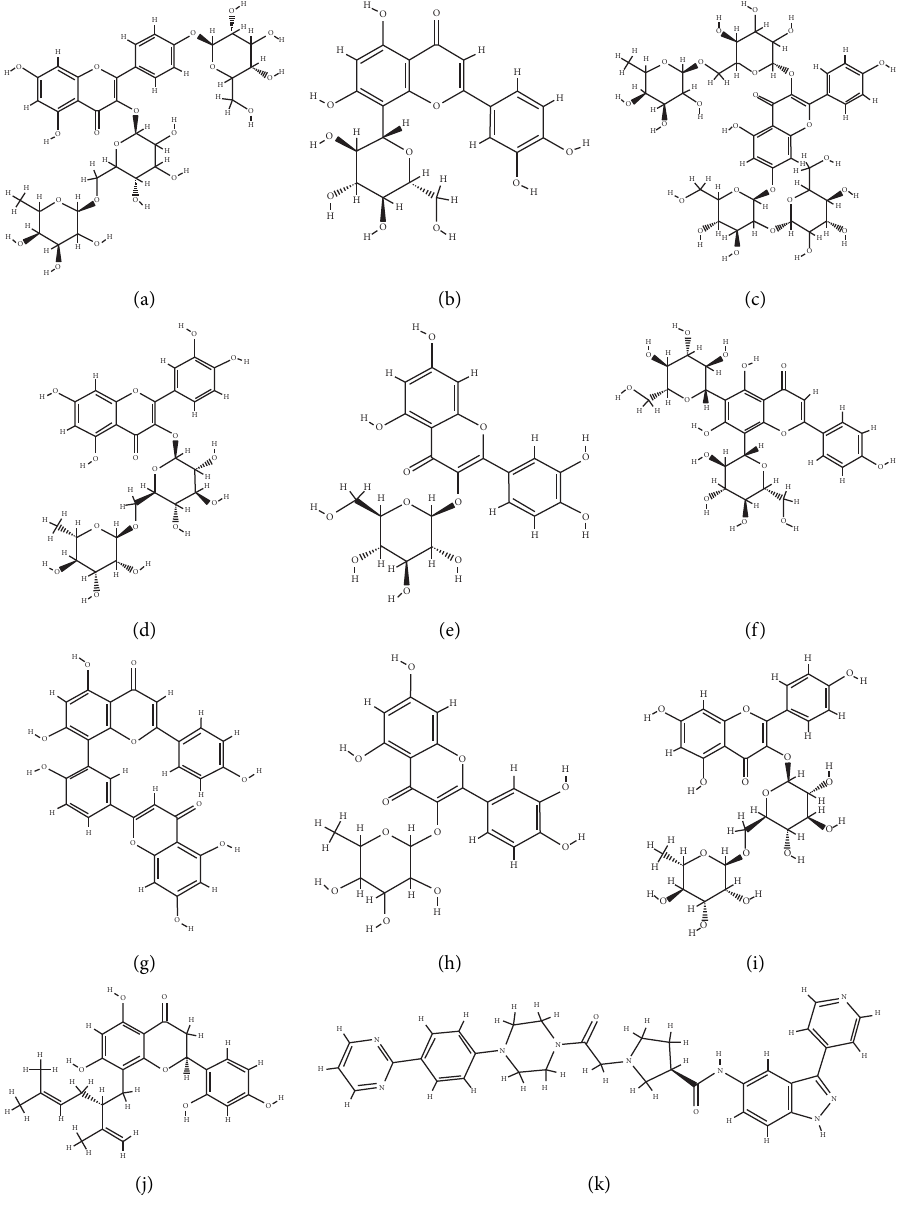
Figure 1: Chemical structures of (a) kaempferol 3-rutinoside-4 ′ -glucoside, (b) orientin, (c) kaempferol 3-rutinoside-7-sophoroside, (d) rutin, (e) isoquercitrin G, (f) vicenin-2, (g) amentofavone, (h) quercetin-3-rhamnoside, (i) nicotiforin, (j) sophorafavanone G, and (k) the standard drug